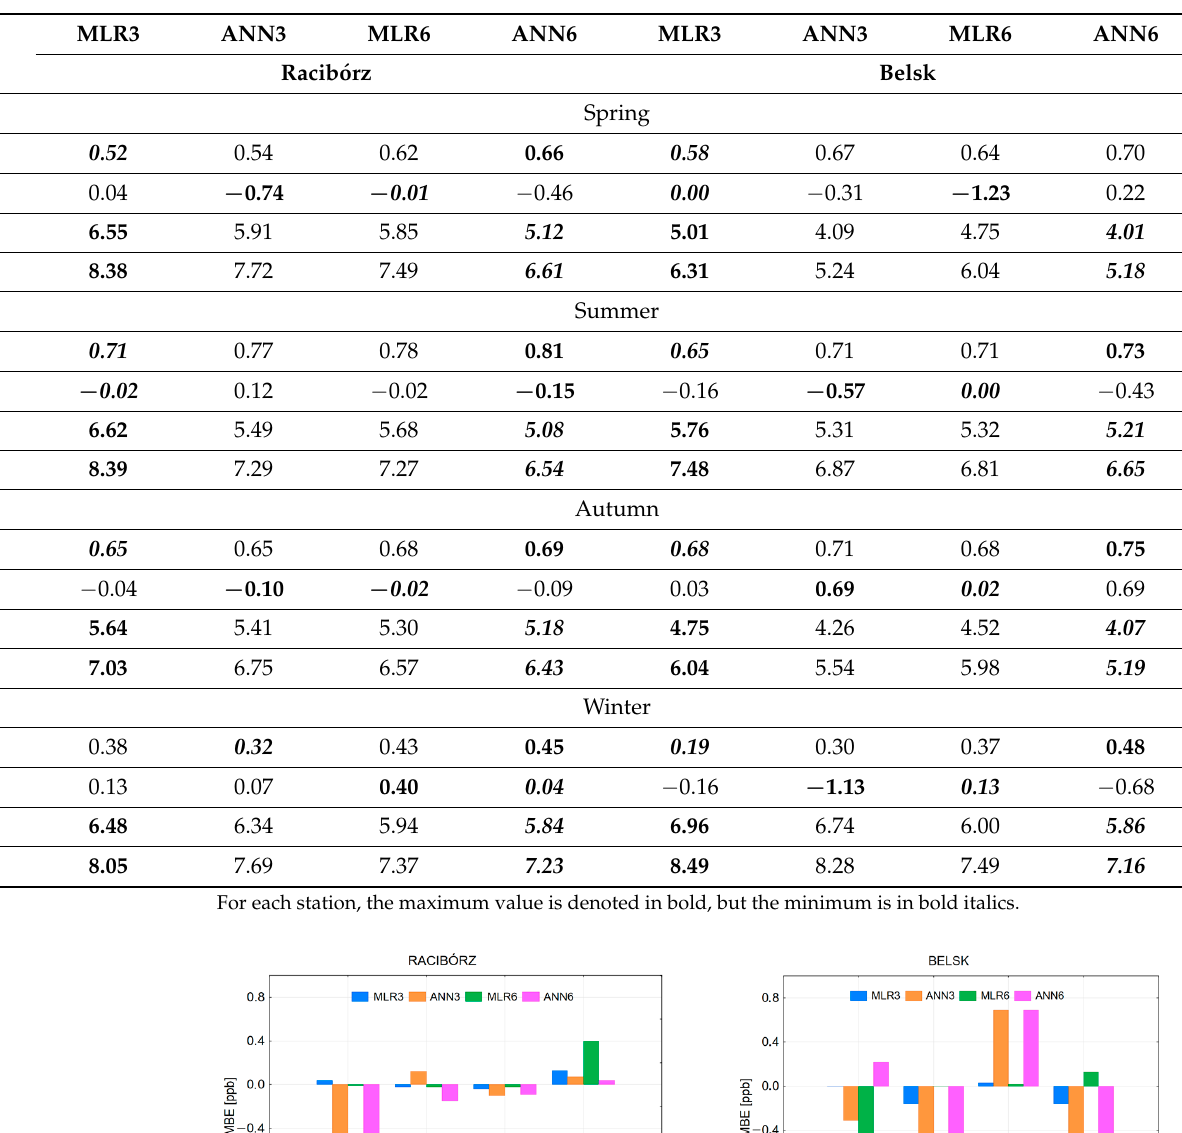
Table 4. Comparative statistics for MLP and ANN models for validation subset (MLR 3 = multiple linear regression with an input data set consisting of three predictors, ANN 3 = artificial neural network with an input data set consisting of three predictors, MLR 6 = multiple linear regression with an input data set consisting of six predictors, ANN 6 = artificial neural network with an input data set consisting of three predictors). MBE, MAE and RMSE are in ppb.